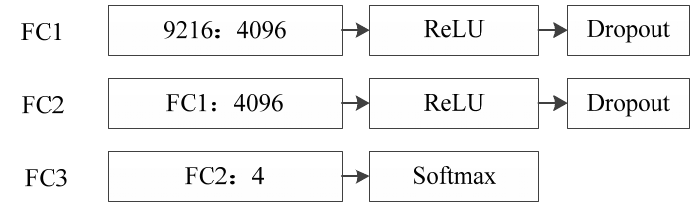
Figure 8. Optimized AlexNet full connection layer.